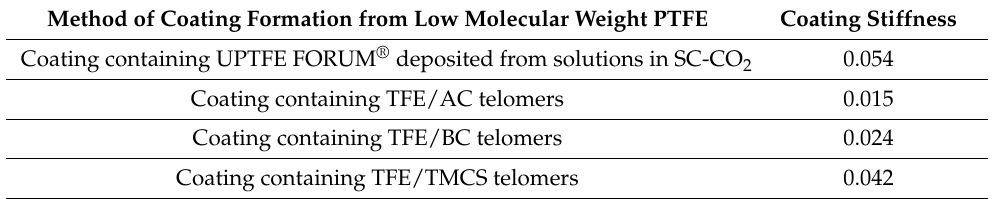
Table 3. Stiffness of the coatings formed on the polyester fabric by different methods from solutions of low molecular weight PTFE.